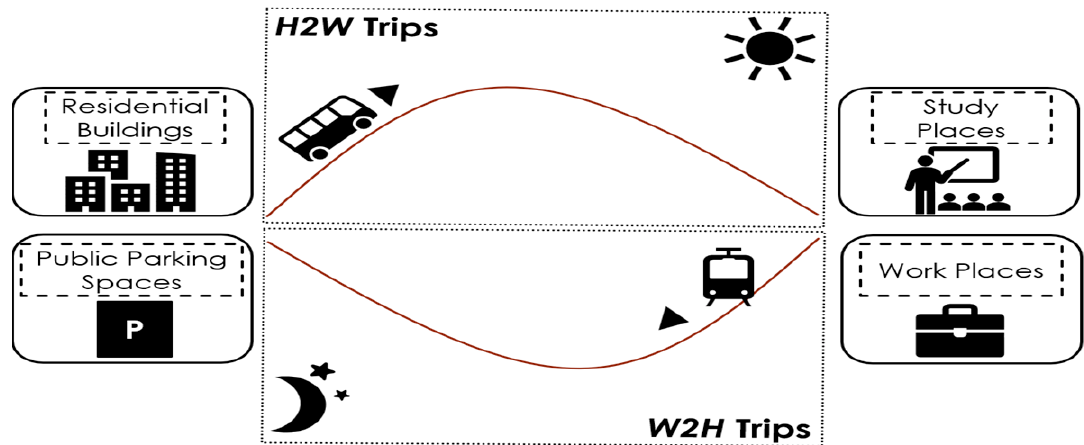
Figure 2. W2H and H2W trips.